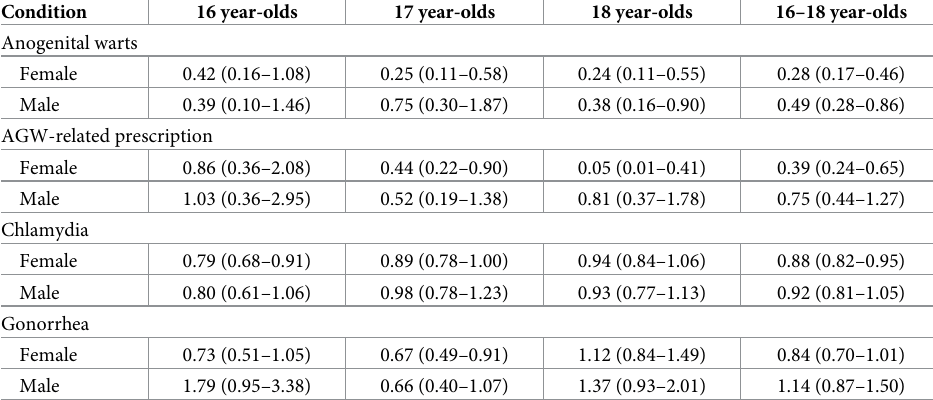
Table 2. Incidence rate ratios (95% confidence interval) of certain conditions for cohorts 2 years before and after the introduction of school-based qHPV vaccination (birth cohorts 1997–1998 vs 1995–1996) by gender.